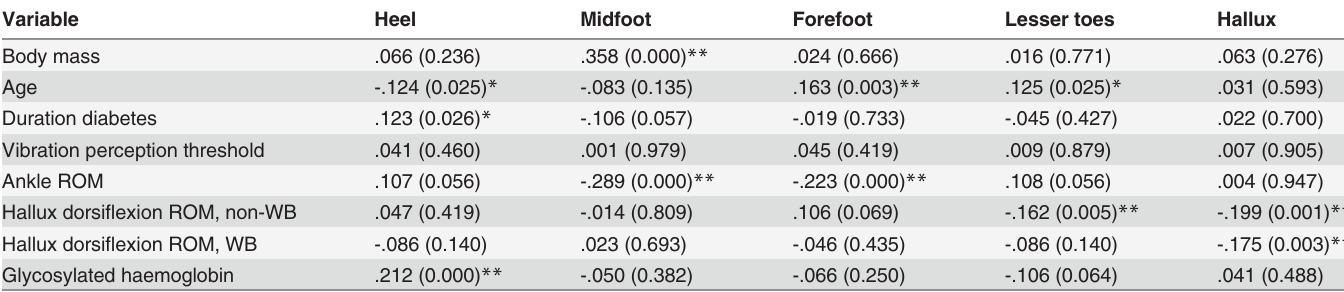
Table 3. Summary of correlations between barefoot plantar peak pressure and continuous predictor